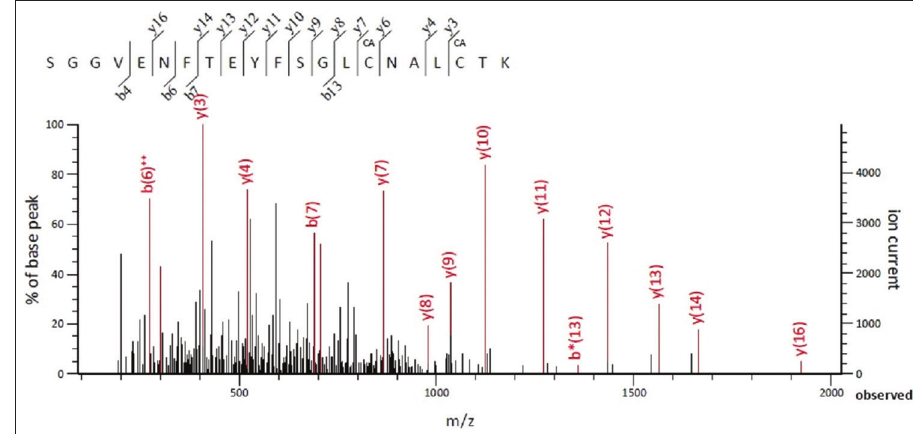
Figure-4: Liquid chromatography and tandem mass spectrometry spectrum of rP32Trx frameshiftprotein.